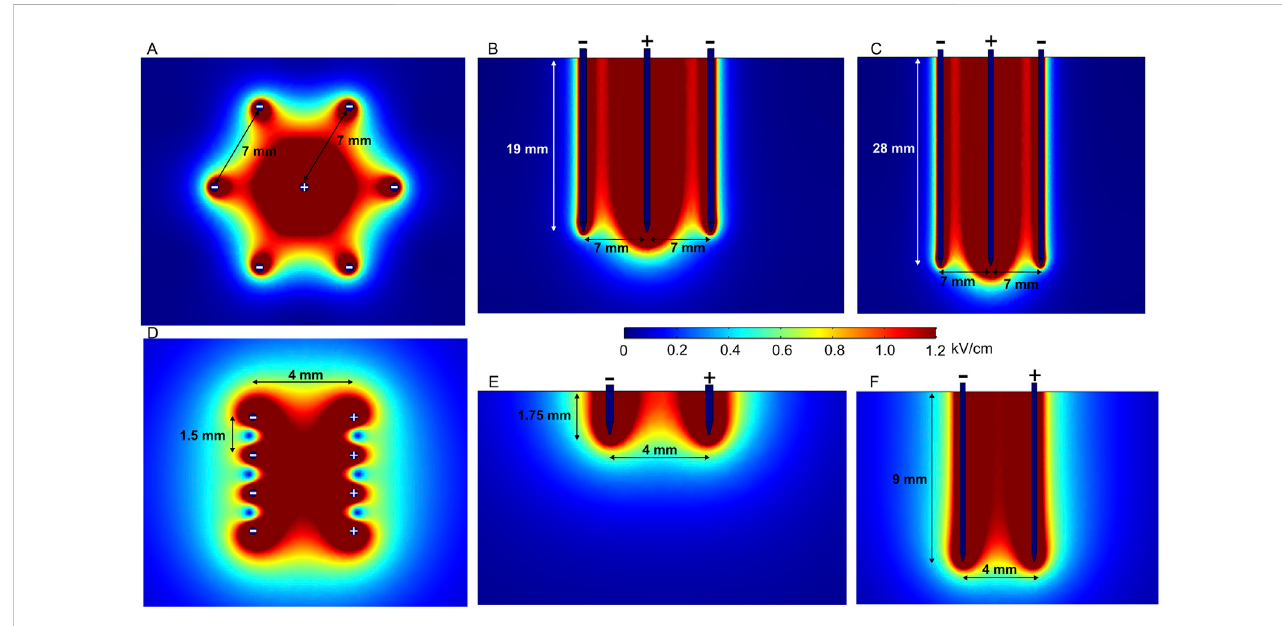
FIGURE 6 Spatial electric fi eld distribution generated by hexagonal and intradermal needle-type electrode arrays with 1500 V and 600 V terminal voltages, respectively, taking into account different depths of penetration. (A) Hexagonal electrodes, top view; (B) hexagonal 20-mm-length electrodes, side view; (C) hexagonal 30-mm-length electrodes, side view; (D) intradermal electrodes, top view; (E) intradermal 2-mm-length electrodes, side view; (F) intradermal 10- mm-length electrodes, side